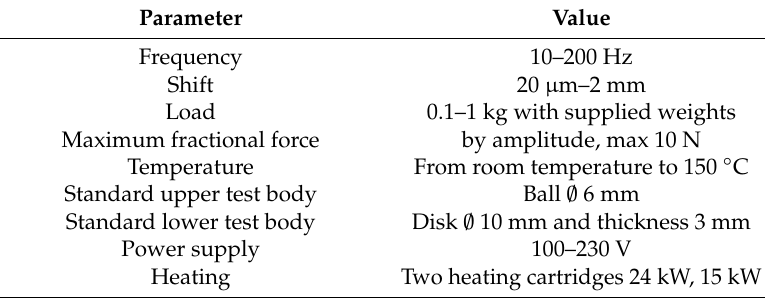
Table 3. Technical parameters of